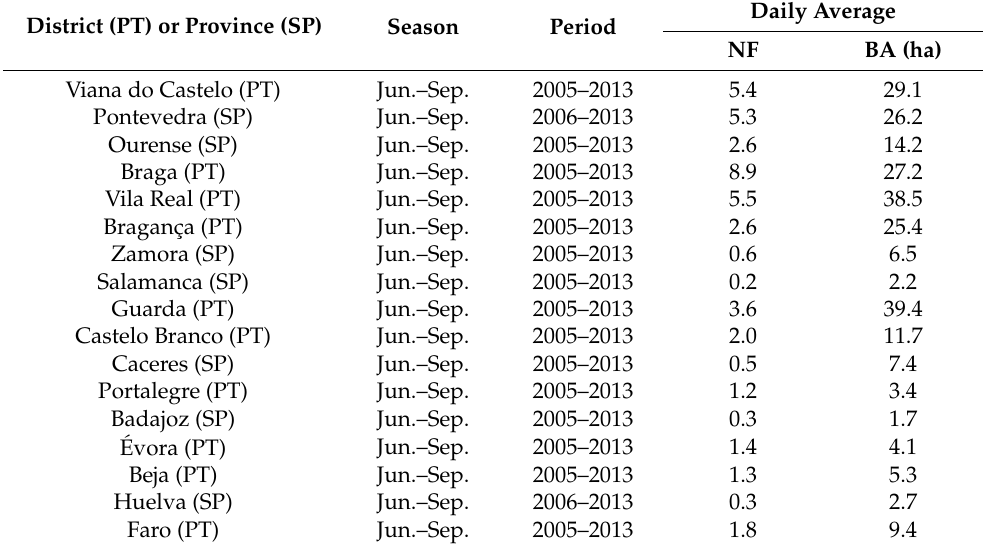
Table 1. Temporal scale and daily average number of fires (NF) and burned area (BA) in the study